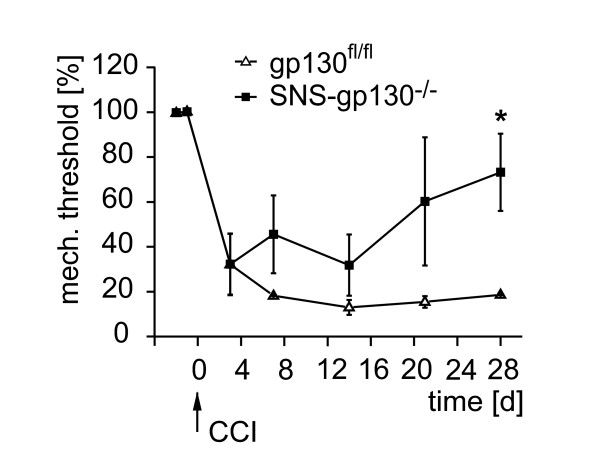
Mechanical hyperalgesia in neuropathic pain model required neuronal gp130. After chronic constriction injury (CCI), SNS-gp130-/- mice (black square, n = 14) showed significant recovery in comparison to gp130fl/fl mice (open triangle, n = 13, * p < 0.05; *** p < 0.001; ANOVA and post-hoc Tukey test).